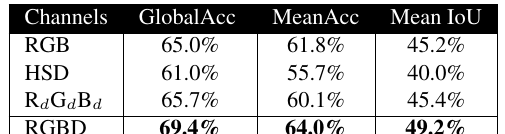
Table 6. Accuracy per class in test T2 (10% of the dataset for training and 90% for testing).